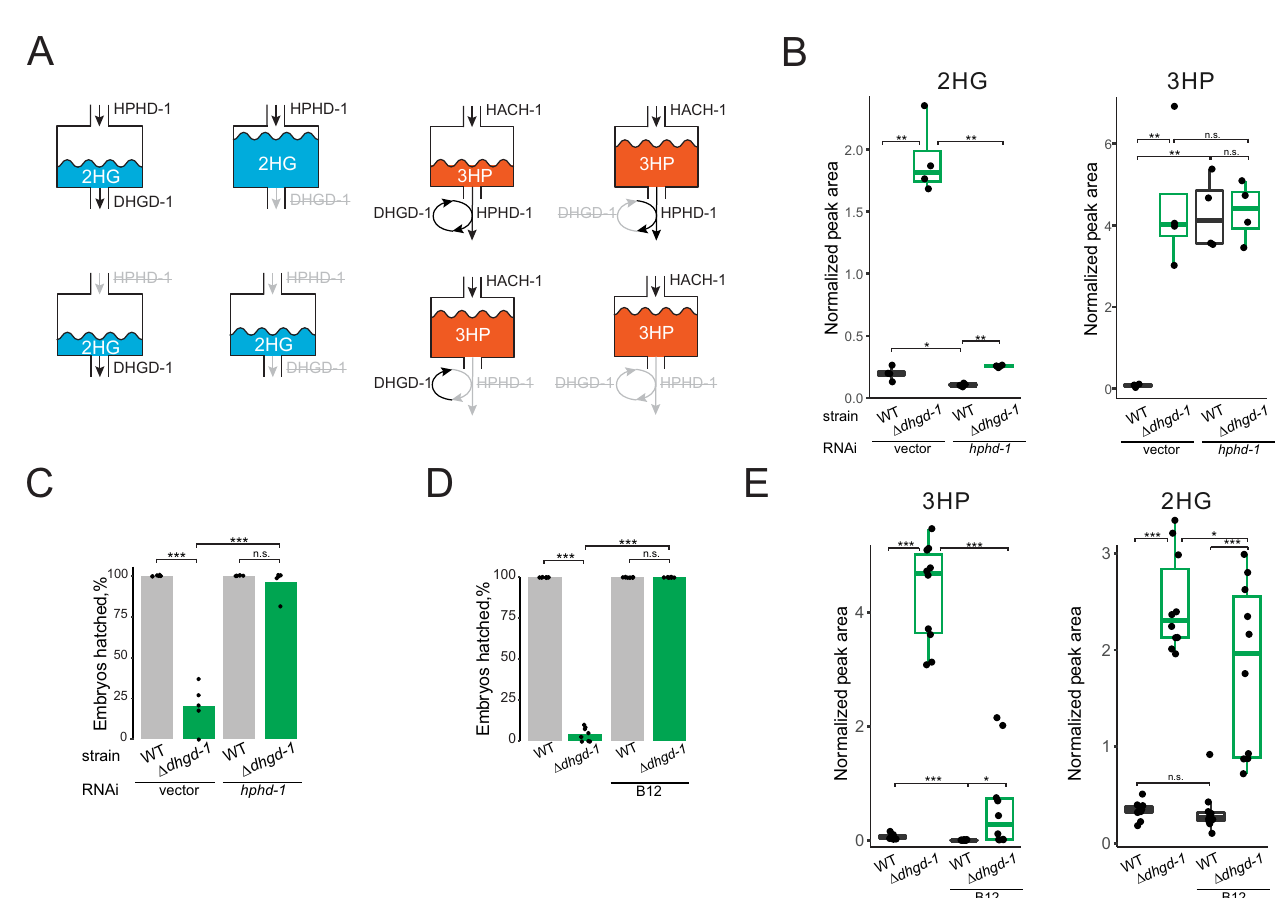
Fig 3. Rescue of lethality in Δ dhgd-1 mutants by vitamin B12 supplementation and hpdh-1 RNAi. (A) Schematic of predicted HPHD-1 and DHGD-1 contributions to 2HG (blue) and 3HP (orange) accumulation. HPHD-1 is a main source of 2HG, and therefore, its knockdown prevents 2HG accumulation in case of DHGD-1 dysfunction. 3HP is expected to accumulate if either DHGD-1 or HPHD-1 is perturbed because these reactions are coupled to facilitate 3HP oxidation. (B) 2HG and 3HP abundance in Δ dhgd-1 mutants upon RNAi of hphd-1 . Boxplot midline represents median of 4 independent biological replicates (dots). (C) hphd-1 RNAi rescues lethality in Δ dhgd-1 mutants. The RNAi-compatible E . coli OP50 strain [34] was used because conventional RNAi-compatible E . coli HT115 rescued embryonic lethality of Δ dhgd-1 animals. Each dot represents an independent biological replicate and bars indicate means. (D) Vitamin B12 rescues lethality in Δ dhgd-1 mutants. Each dot represents an independent biological replicate and bars indicate means. (E) 3HP and 2HG abundance in Δ dhgd-1 mutants supplemented with vitamin B12. Boxplot midline represents median of independent biological replicates (dots). All panels: The means of 3 or more groups were compared with ANOVA, followed by unpaired t test ( * p < 0.05, ** p < 0.01, *** p < 0.001). The data underlying Fig 3B–3E can be found in S1 Data . WT, wild